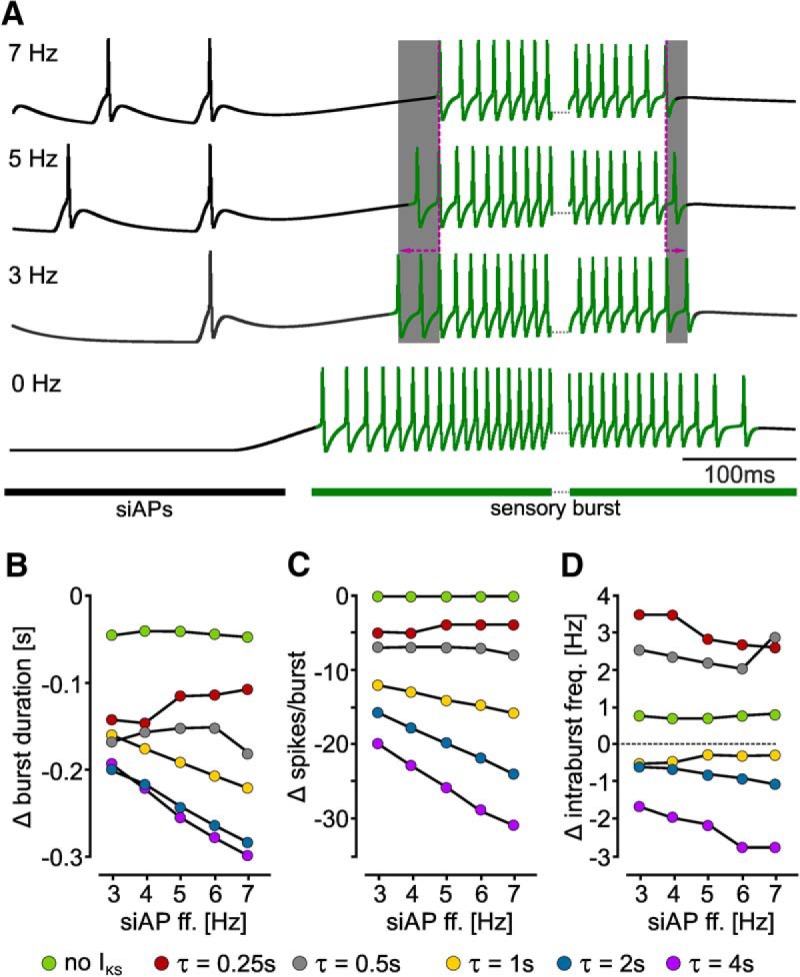
Slow ionic conductances determine the effectiveness of ectopic APs on burst activity. A, Burst activity of three models with an IKS time constant of 2 s. siAP frequency was varied from 7, to 5, to 3 Hz, and compared to 0 Hz (no firing). siAPs are depicted in black, sensory burst APs are highlighted in green. Note that decreasing siAP ff. increased burst duration (gray area). For better visualization, only burst starts and ends are shown. B–D, Analysis of changes in burst structure for different IKS time constants at different siAP frequencies. B, Burst duration. C, Number of spikes per burst. D, Average intraburst ff.